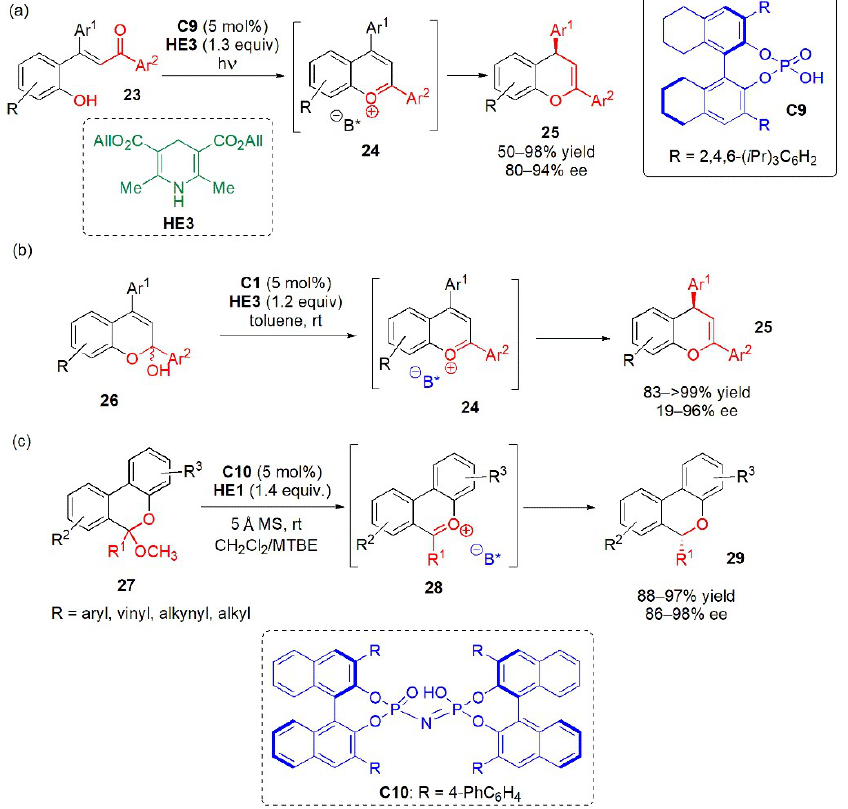
Figure 12. ( a ) Light-assisted asymmetric ion-pair catalysis in the ETH of pyrilium ions to produce chiral 4 H -chromenes [67]; ( b ) Synthesis of chiral 4 H -chromenes from racemic 2 H -chromen-2-ols [68]; ( c ) Synthesis of chiral benzo[ c ]chromenes by ETH [69]. B = Chiral acid catalyst counteranion.